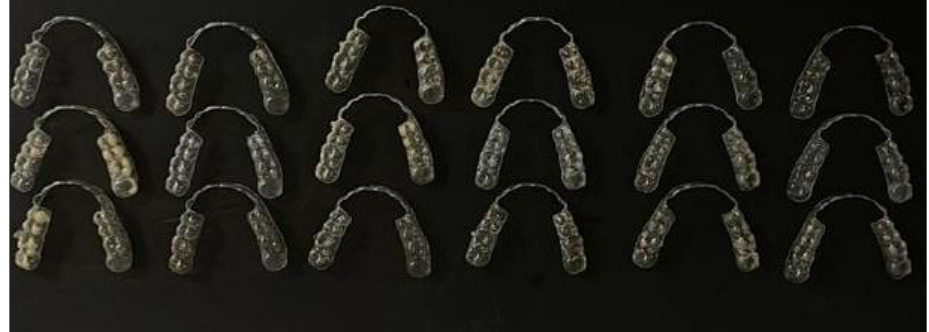
Figure 3. The 18 aligner after aging.